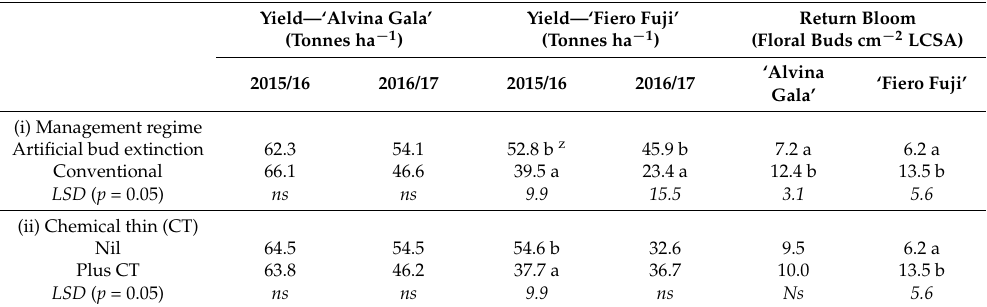
Table 4. Effect of management regime and thinning method on fruit set and final crop load of ‘Fiero Fuji’ (Trial 3). LCSA = limb cross-sectional area. Table 5. Effect of management regime and thinning method on yield and return bloom of ‘Alvina Gala’ and ‘Fiero Fuji’ (Trials 2 and 3). LCSA = limb cross-sectional area.